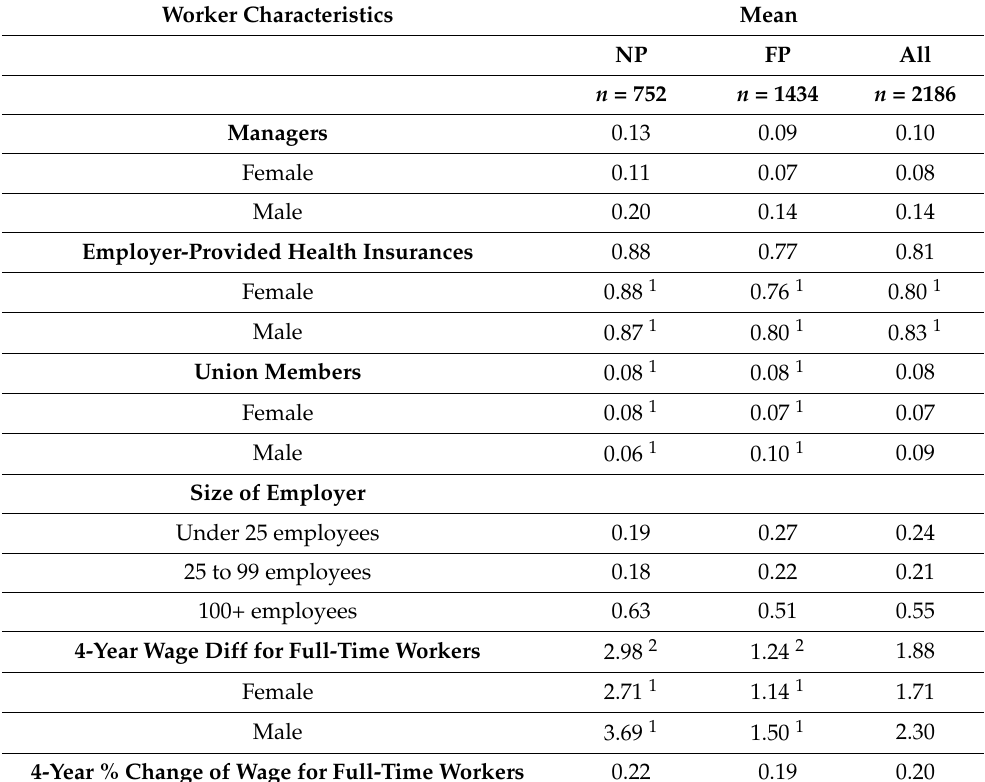
Table 2. Baseline worker characteristics of NP Stayers and FP Stayers (Part